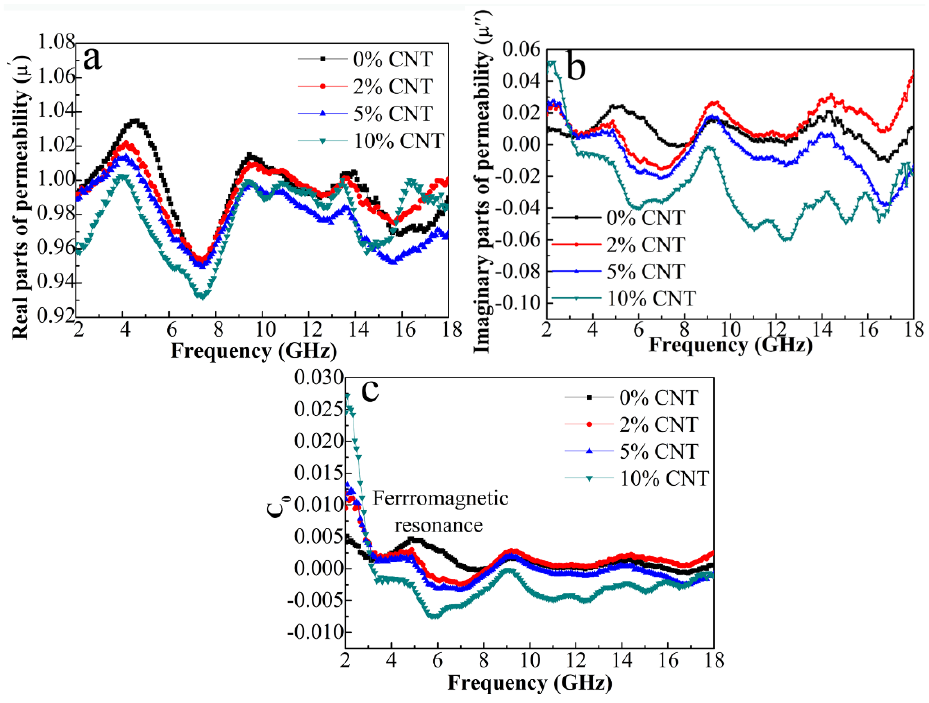
Figure 9. Frequency reliance of ( a ) µ′ , ( b ) µ′′ , and ( c ) C 0 for the composites.